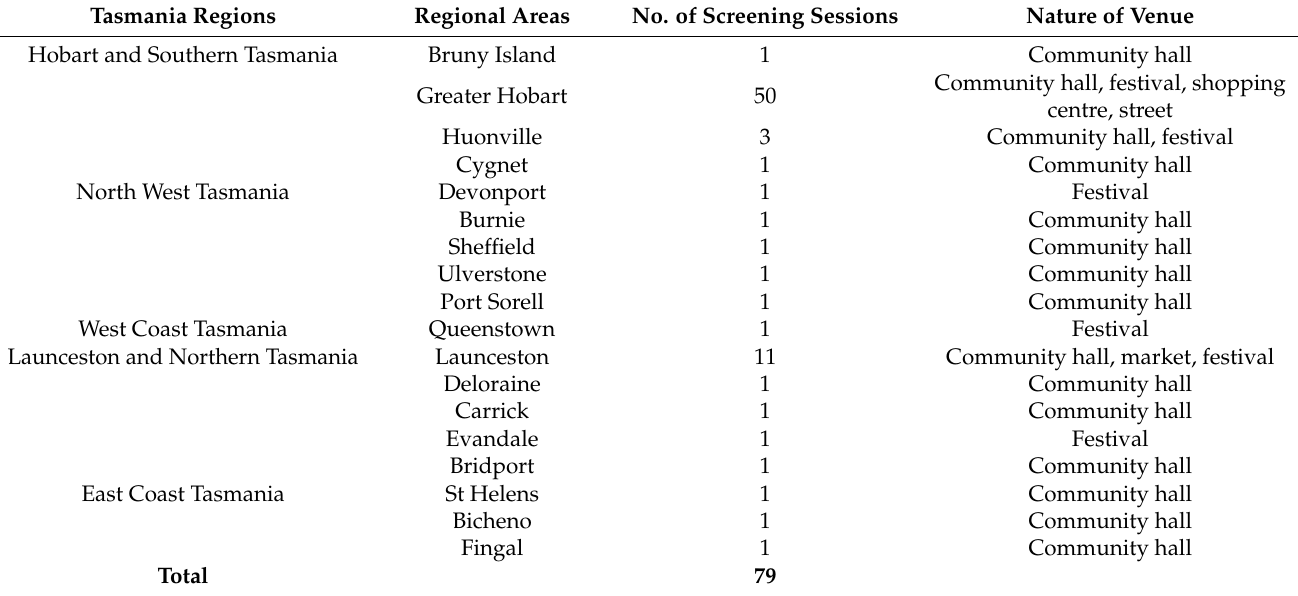
Table 1. Locations of screening sessions.